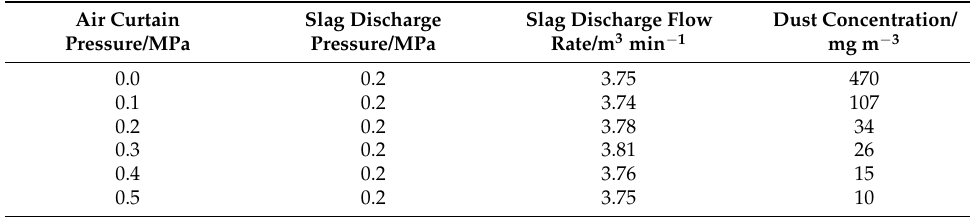
Table 4. Dust control effect with the slag discharge pressure at 0.2 MPa.